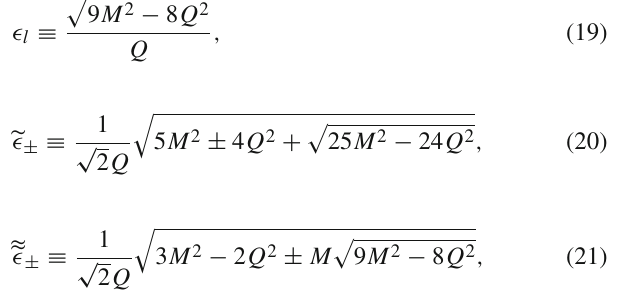
4 Circular motion around a RN naked